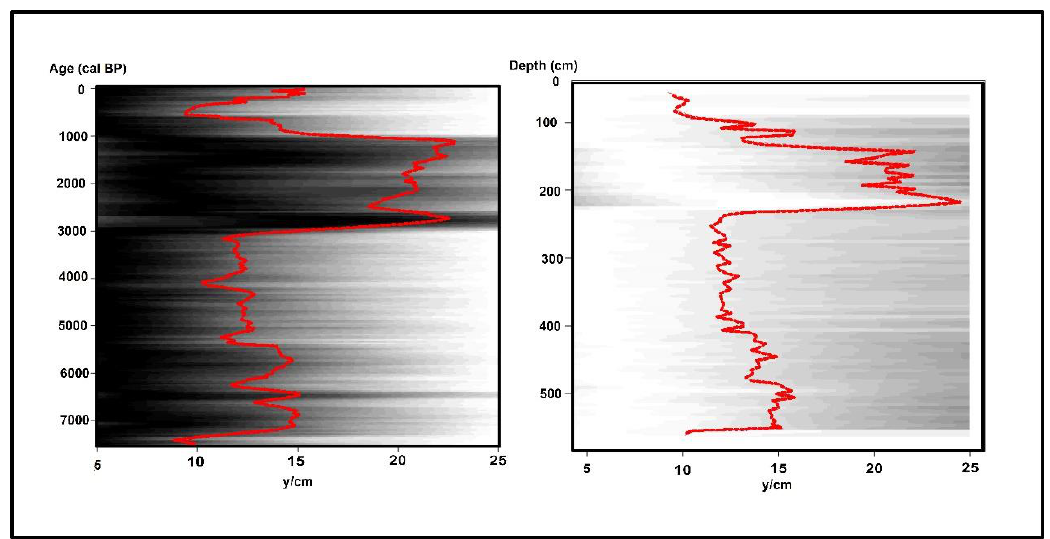
Figure 8. Calculated sedimentation times (yr/cm) (inverse accumulation rate) were estimated from Markov Chain Monte Carlo (MCMC) iterations against age and depth using the Bacon model (red dotted lines: mean values). Table 4. 12 AMS data from undisturbing core sequence of the Round Lake.